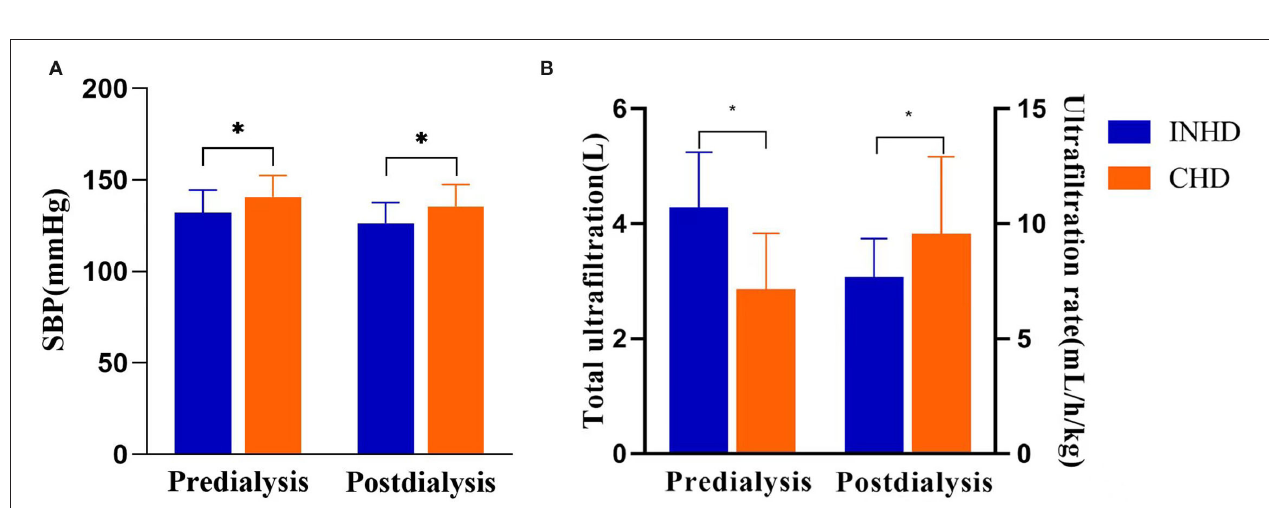
FIGURE 3 | (A) Comparison of systolic blood pressure between patients undergoing INHD and CHD. (B) Comparison of volume control between patients undergoing INHD and CHD. * P < 0.05.